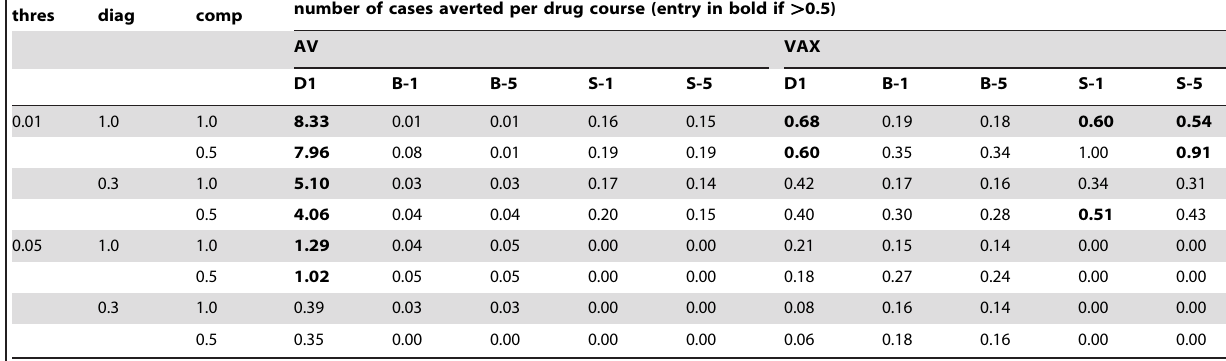
thres diag comp number of cases averted per drug course (entry in bold if . 0.5)